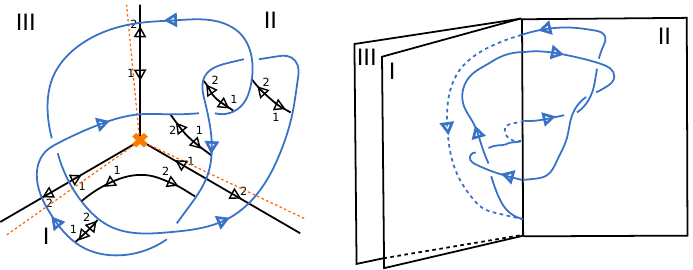
Figure 37 . A (cid:12)gure-eight knot in the neighborhood of a branch point in standard projection (left) and leaf space projection (right).